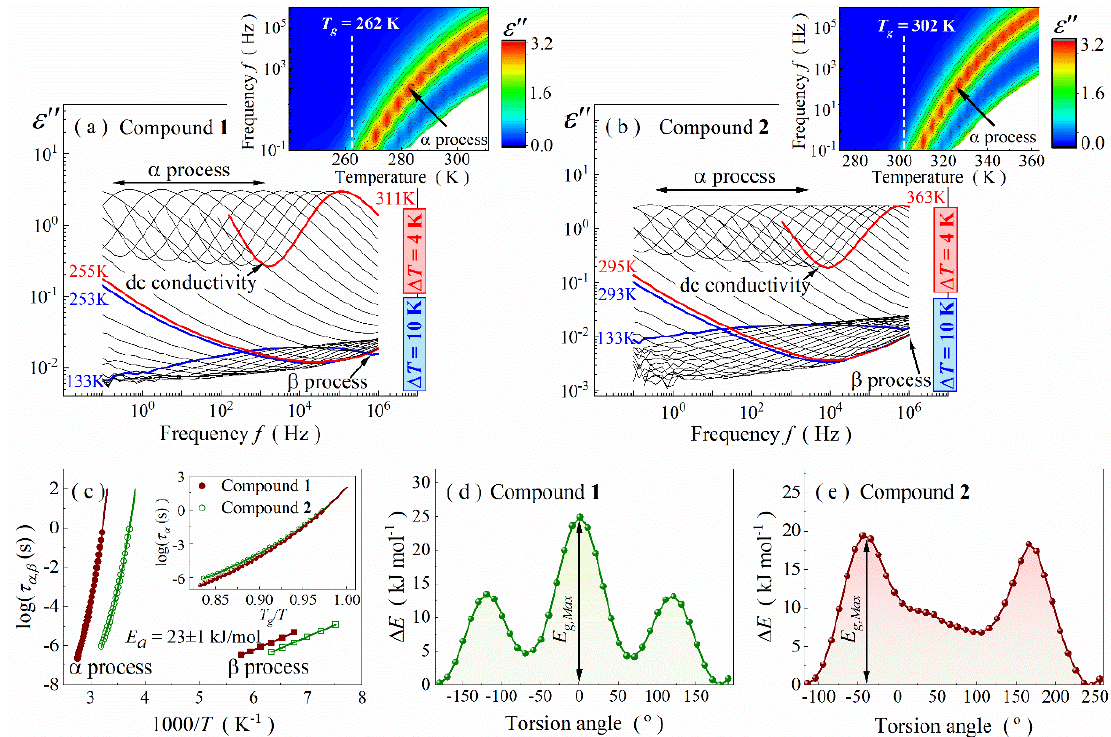
Figure 3. Dielectric loss spectra of compounds 1 ( a ) and 2 ( b ). Insets show temperature evolution of their α-relaxation peak. ( c ) Relaxation map for both Schiff bases with inserted Angell plot. ( d ) Rotational curve inside alkyl -C 4 H 9 substituent (C4-C3-C2-C1 dihedral angular alteration, i.e., around C5-C4 bond) of compound 1. ( e ) Rotational curve for -CH=CH-Ph substituent (C10-C9-C8-C7 dihedral angular alteration, i.e., around C9-C8 bond) in compound 2